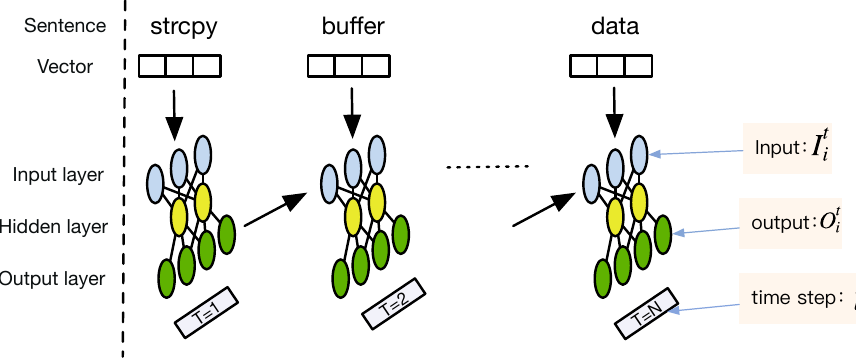
Figure 4. Features of Long Short-Term Memory